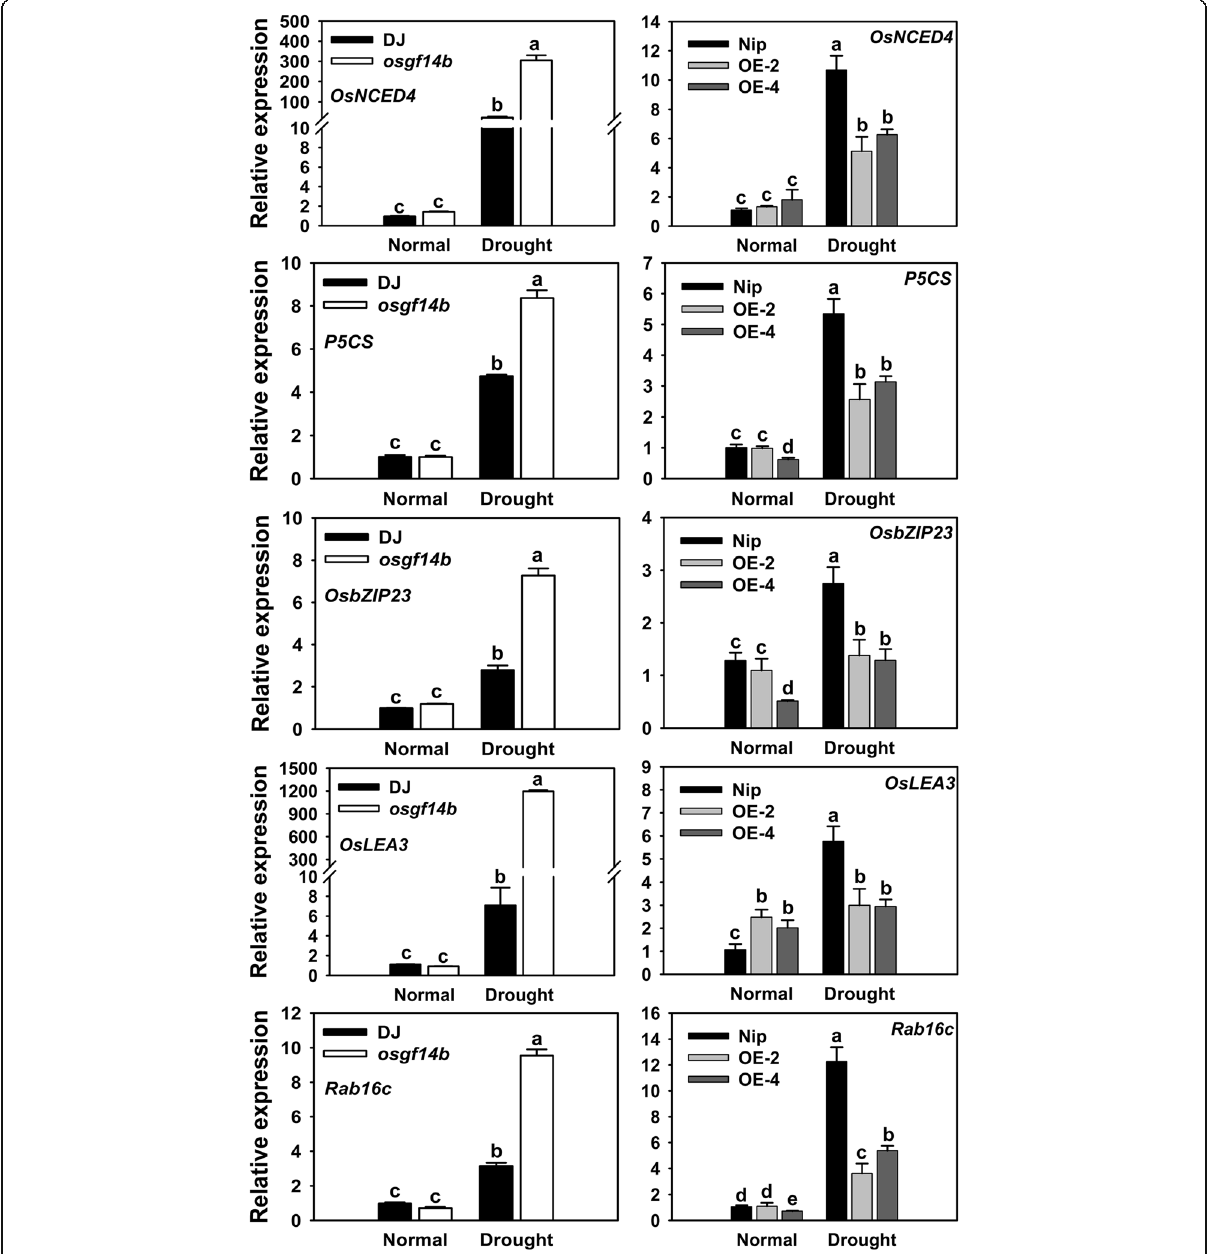
Fig. 3 The expression of abiotic stress-responsive genes in the WT and transgenic plants (mutant and OE) under normal growth and drought stress conditions. The rice Actin1 gene was used as the internal control. Error bars represent the SE of three biological replicates. Statistical differences are labeled with different letters according to the LSD test ( P <0.05, one-way